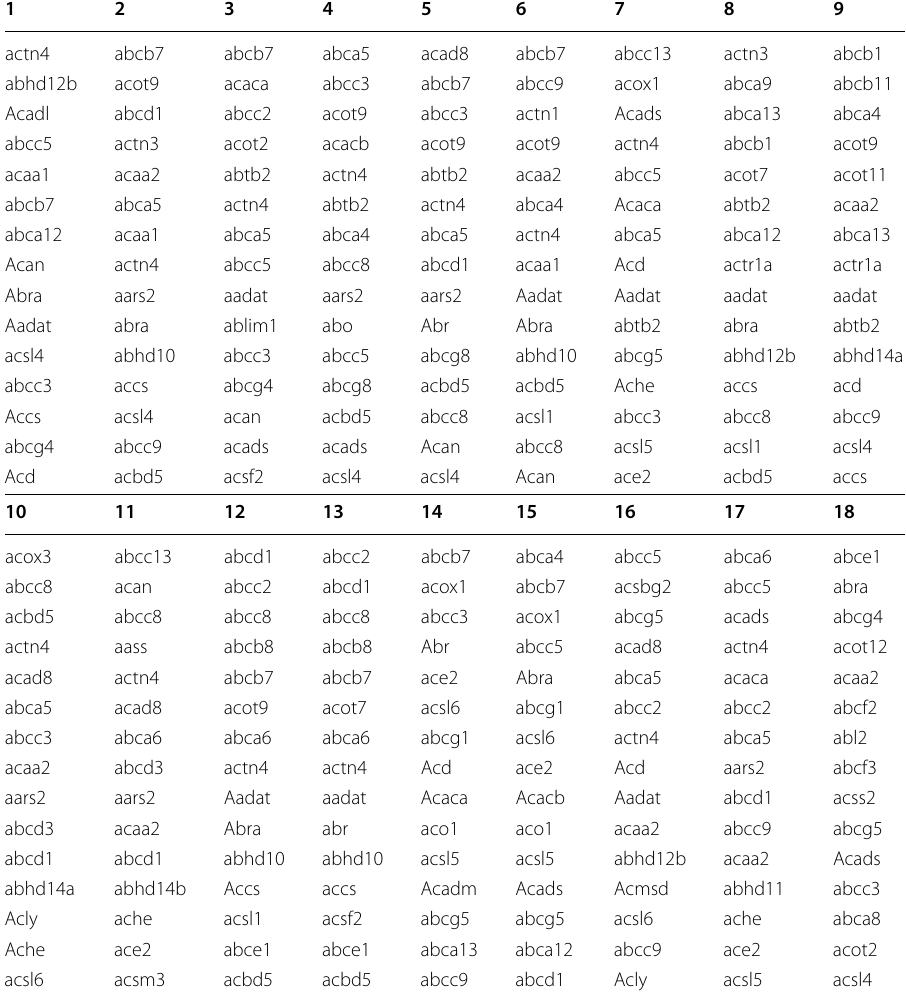
Table 2 Features selected for machine learning purposes. Selected features are obtained using Fisher Score and PCA algorithms,